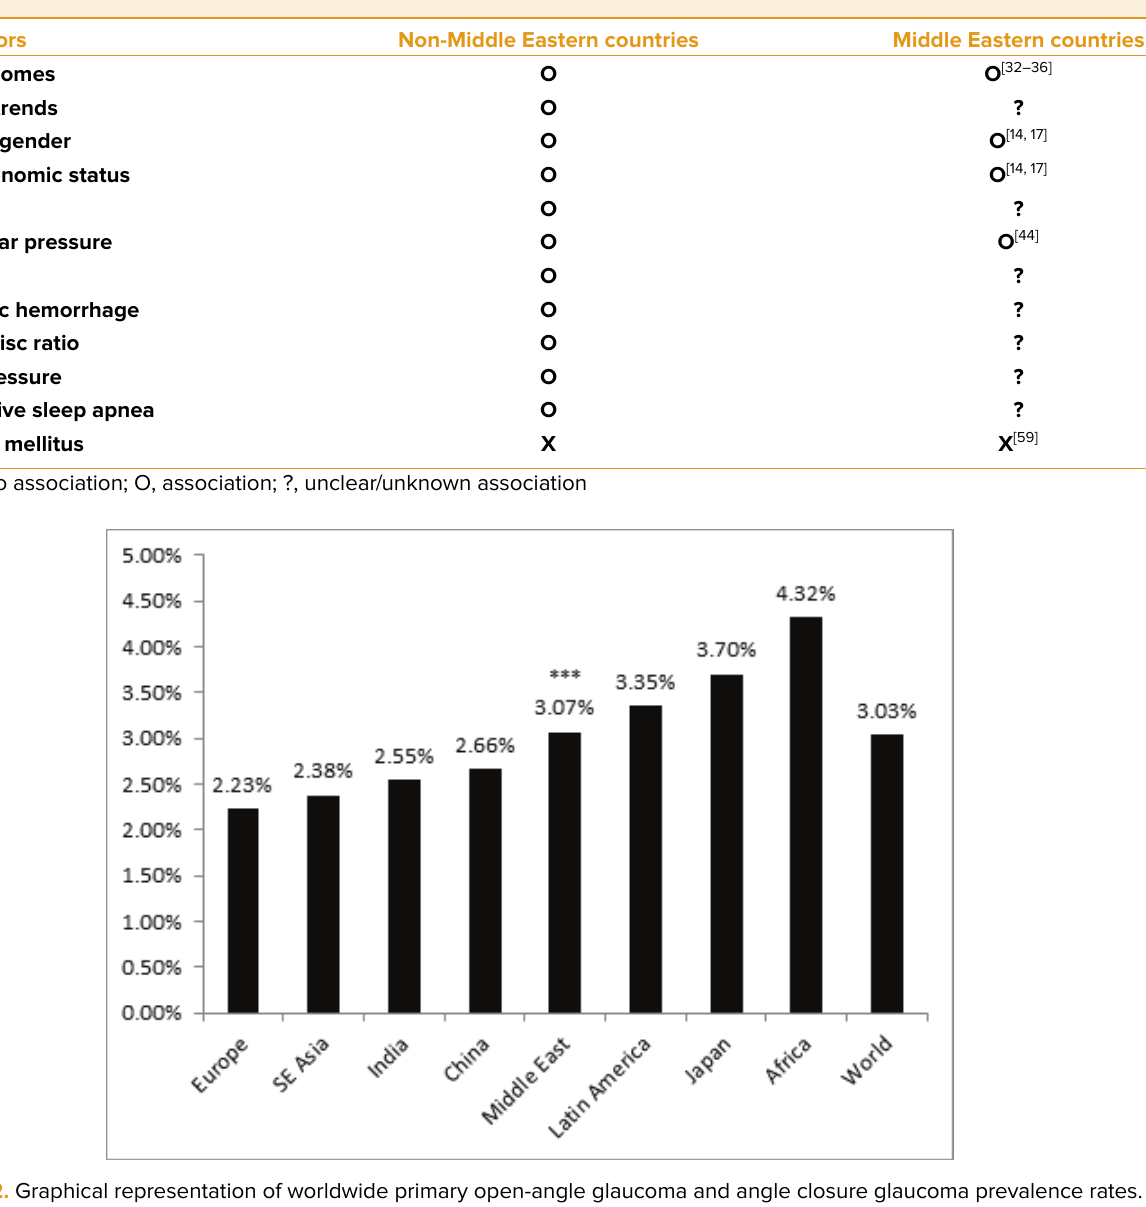
Table 5. Summary of possible risk factors of primary open angle glaucoma in Middle Eastern countries versus non-Middle